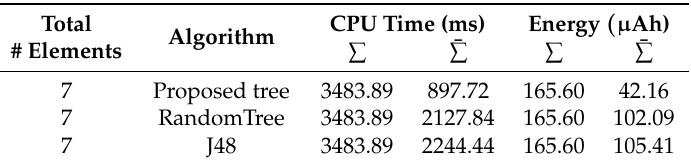
Table 7. Estimation of computational requirements and energy consumption for the different decision